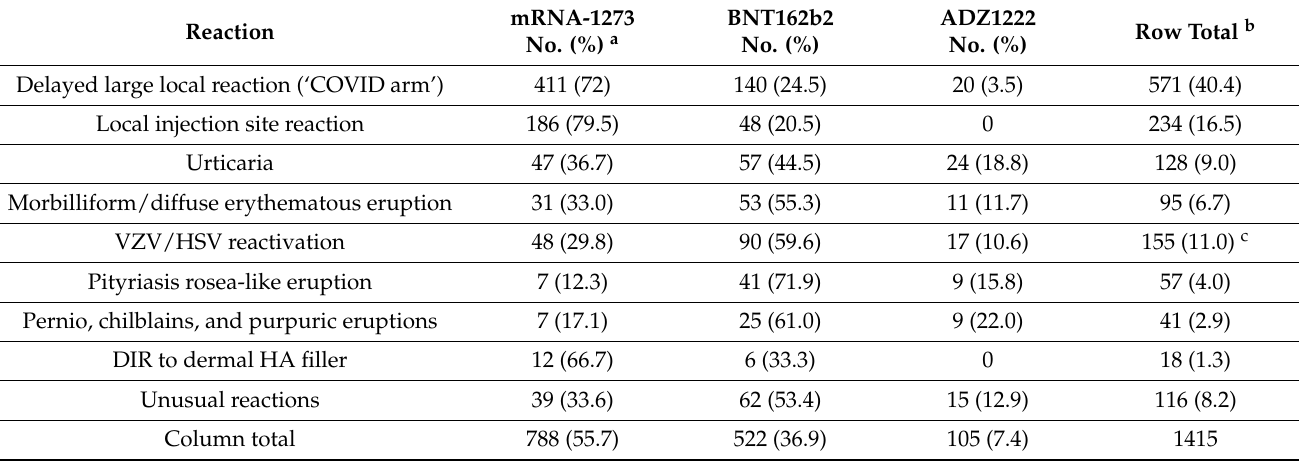
Table 2. Cutaneous reactions by COVID-19 vaccine type.